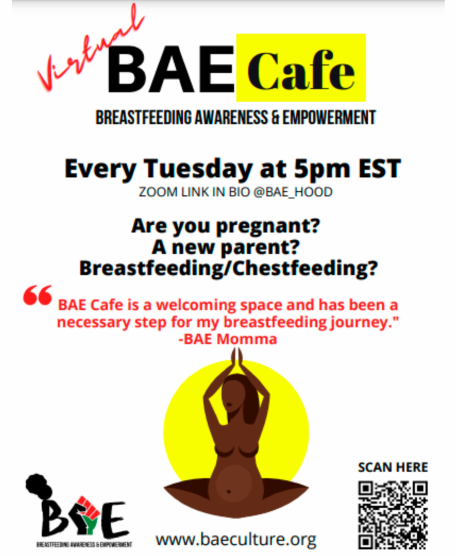
Figure 3. BAE Cafe virtual group